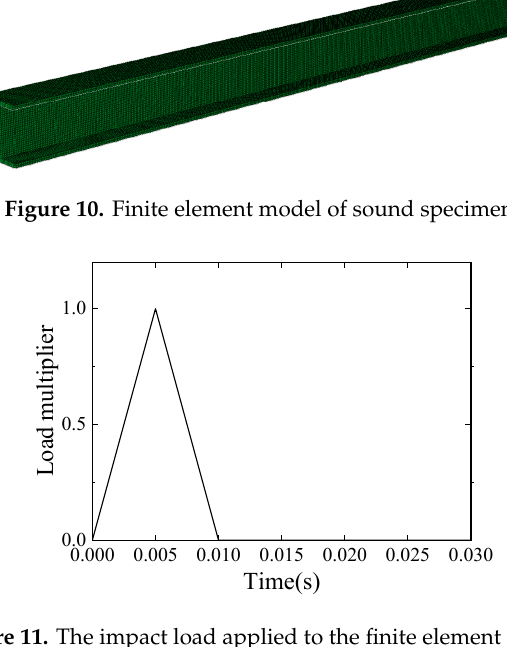
Figure 11. The impact load applied to the finite element model.